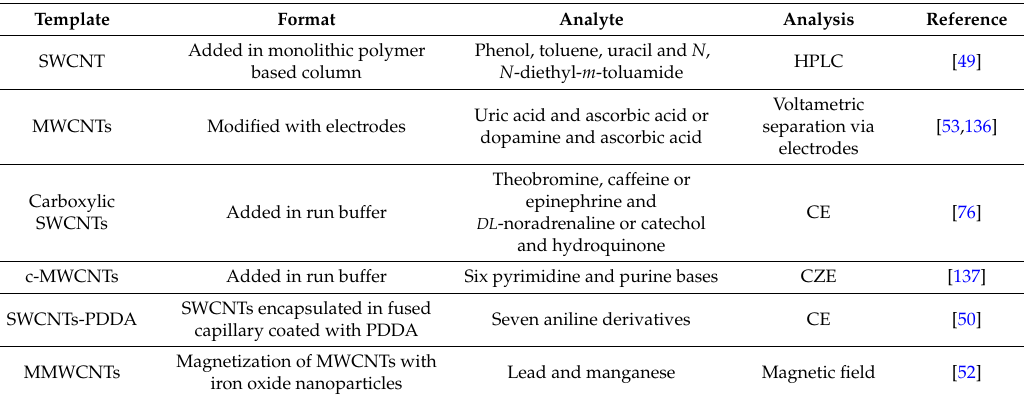
Table 2. Different approaches for achiral separation by